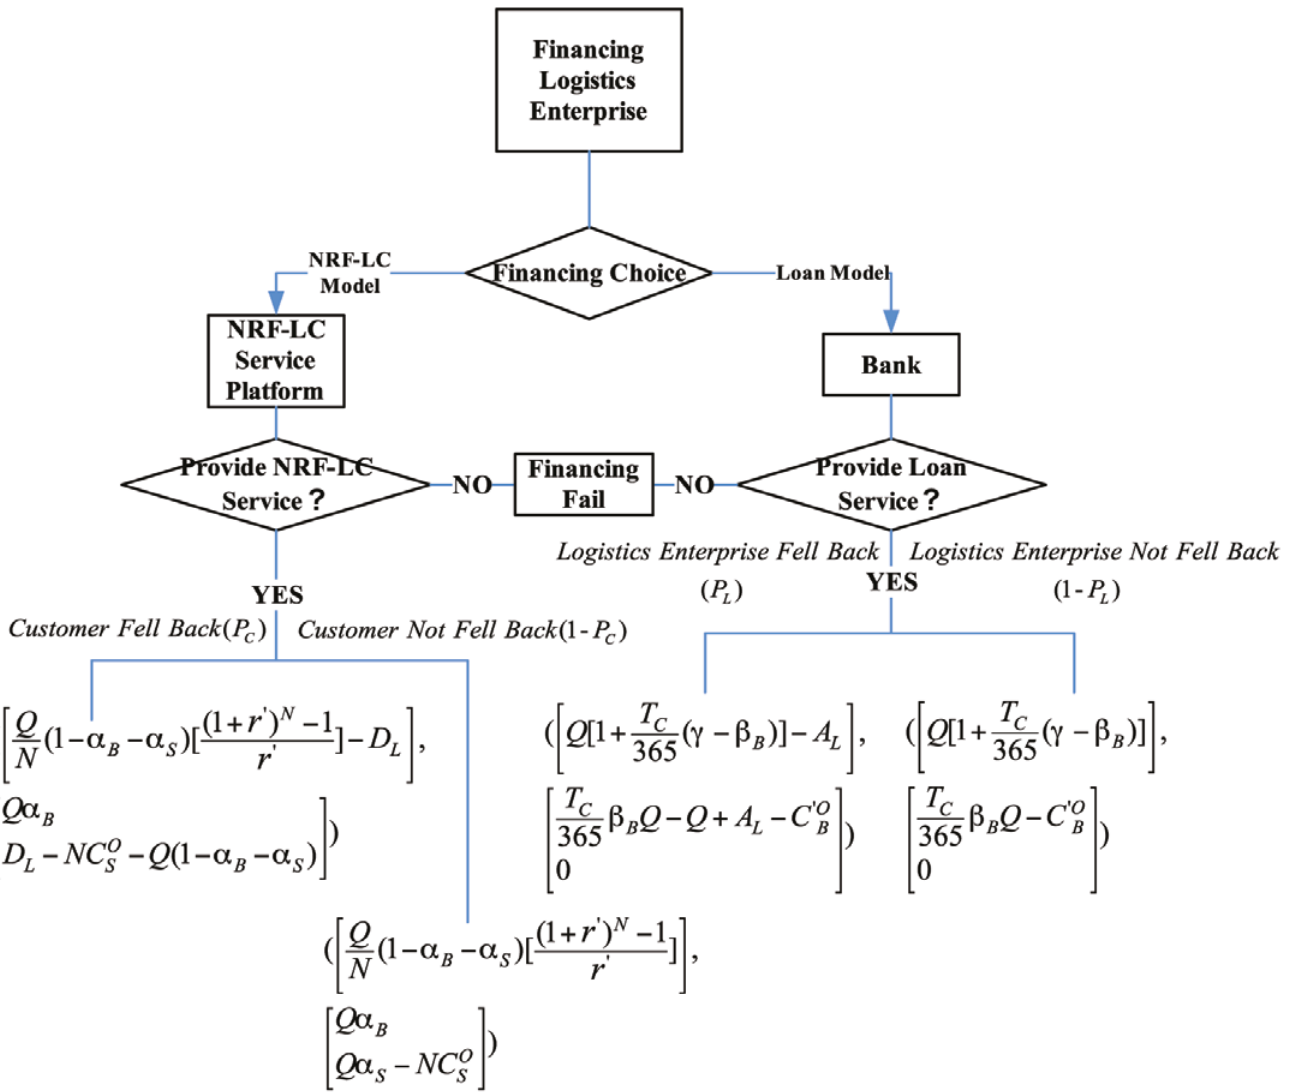
Figure 6: Revenue analysis NRF-LC model versus loan